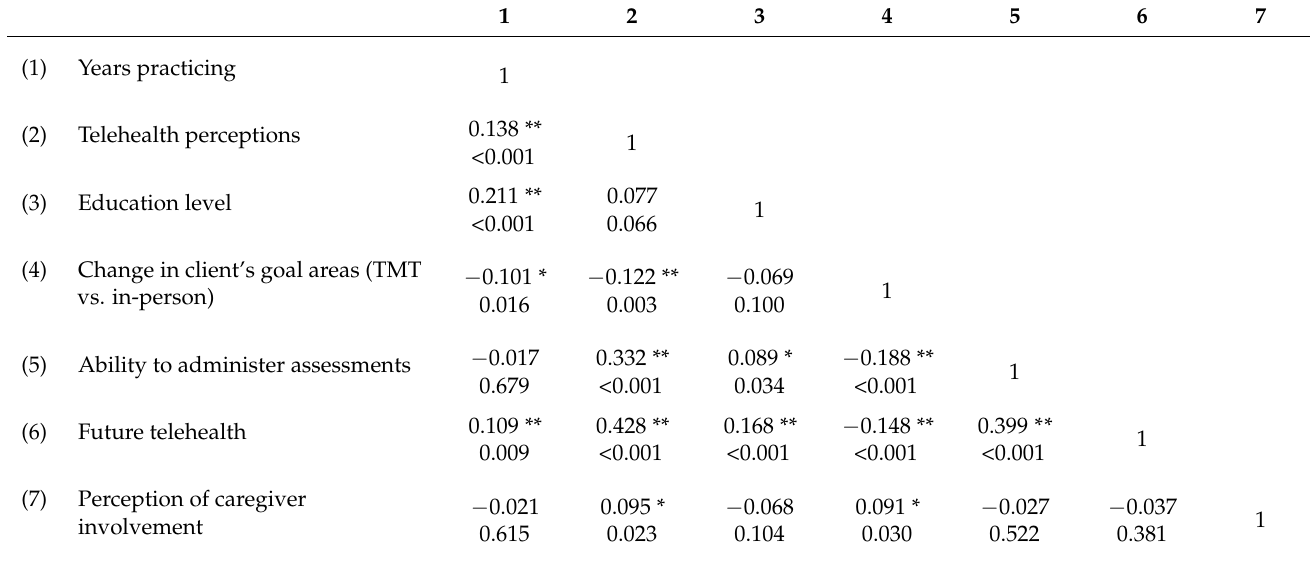
Table 2. Correlations analysis